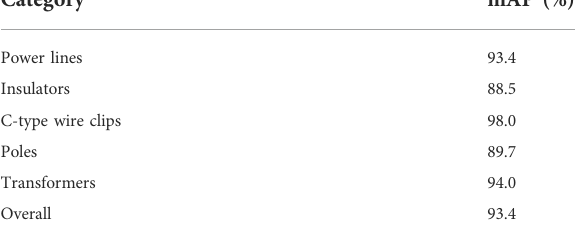
TABLE 2 MAP value of power lines and auxiliary